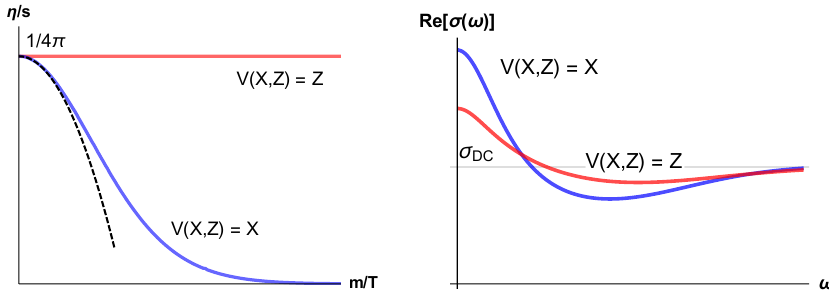
Figure 3 . The di(cid:11)erence between the linear axion model V ( X; Z ) = X [32] and the (cid:13)uid model V ( X; Z ) = Z . Both models break translations explicitly and have a (cid:12)nite DC conductivity. Nev- ertheless the (cid:12)rst violates the Kovtun-Starinets-Son (KSS) bound while the second does not. The violation of the KSS bound in the (cid:12)rst case can be derived analytically (dashed line)